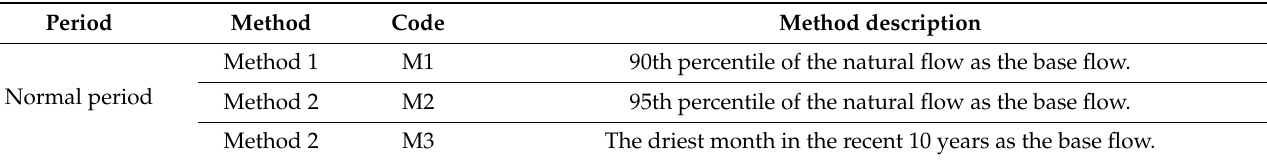
Table 4. Six hydrological methods for the calculation of e-flow scenarios.